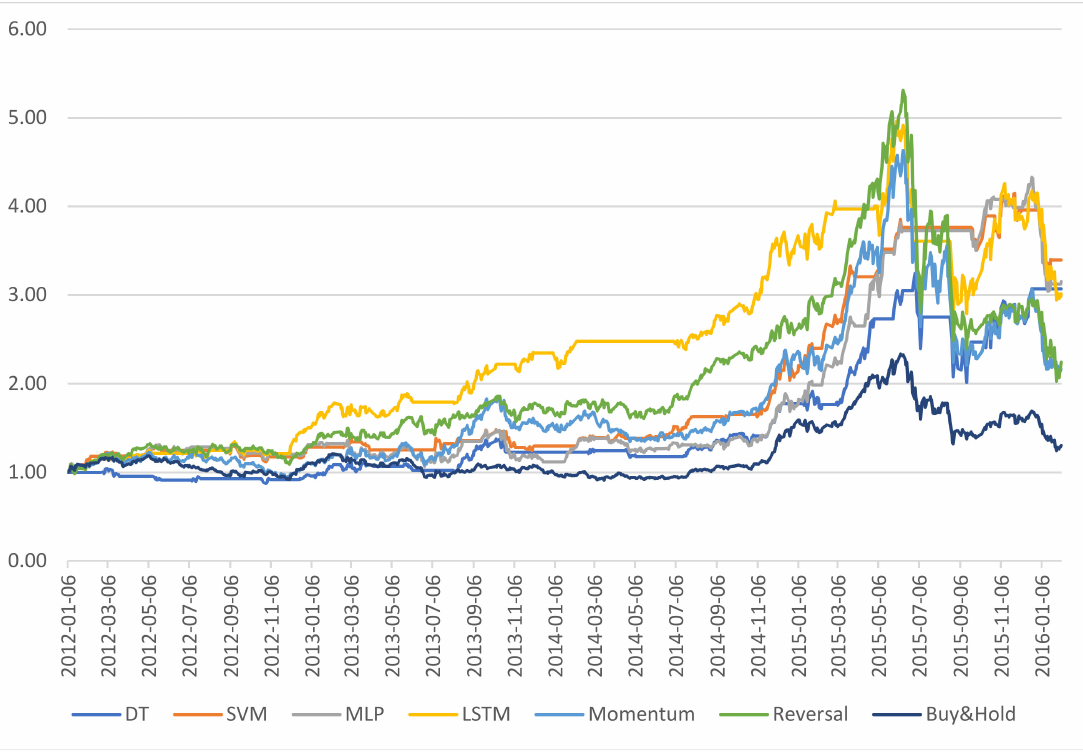
Figure 9. Portfolio performance comparison for the best strategies and